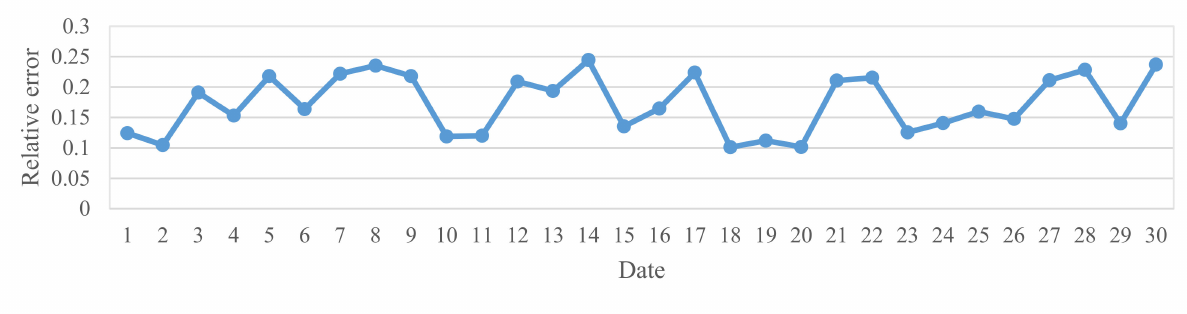
Figure 8. Relative error of cash flow forecast of G company in June 2019.